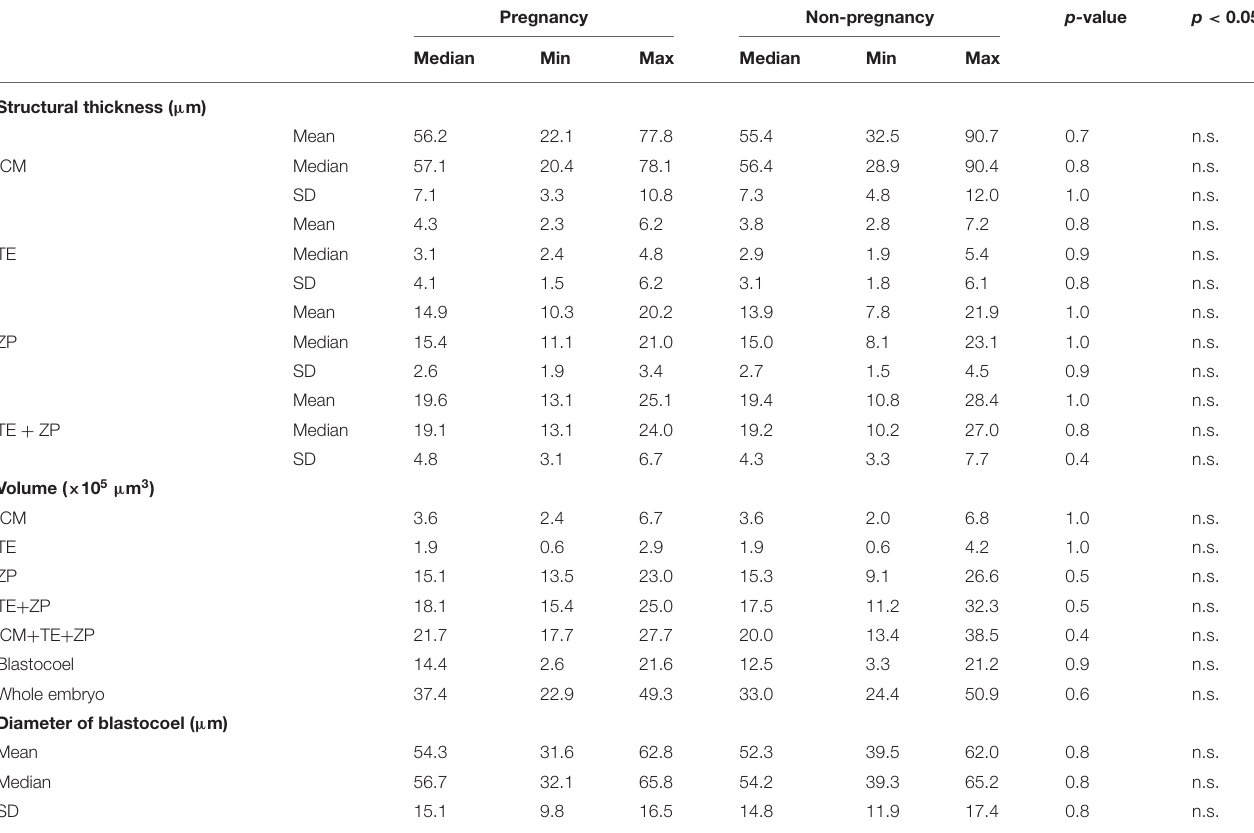
TABLE 1 | Quantification of 22 parameters in bovine embryo (Pregnancy: n = 15, Non-pregnancy: n = 15). Pregnancy Non-pregnancy p- value p < 0.05 Median Min Max Median Min Max Structural thickness ( µ m) Mean